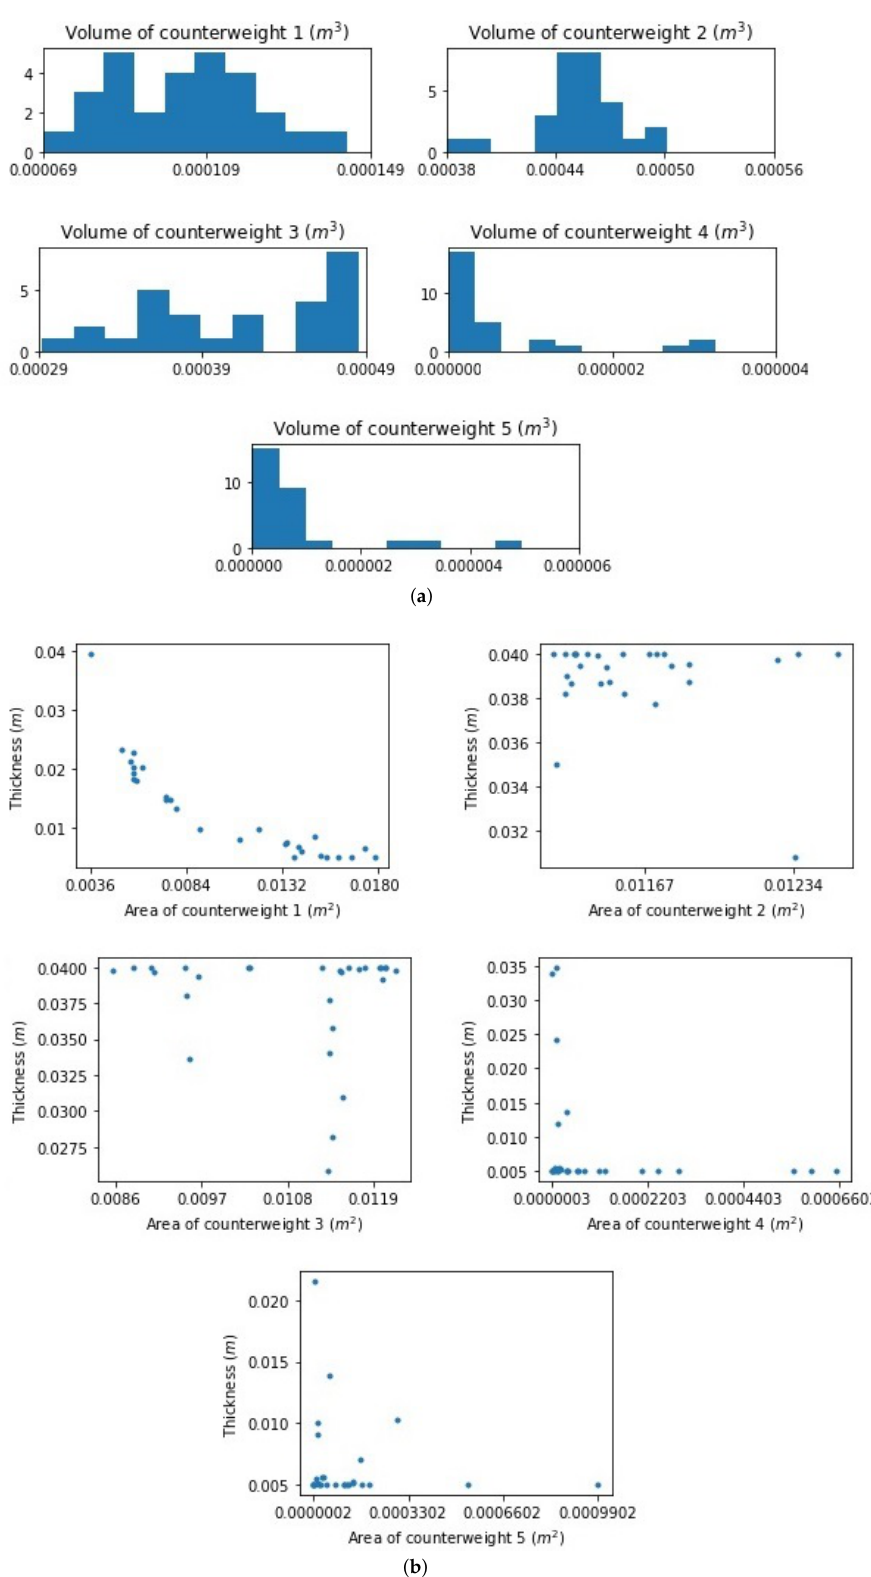
Figure 7. Dimensional analysis for the five counterweights balancing the six-bar mechanism. ( a ) Vol- umes of the five counterweights. ( b ) Relationship between the area and the thickness for the five